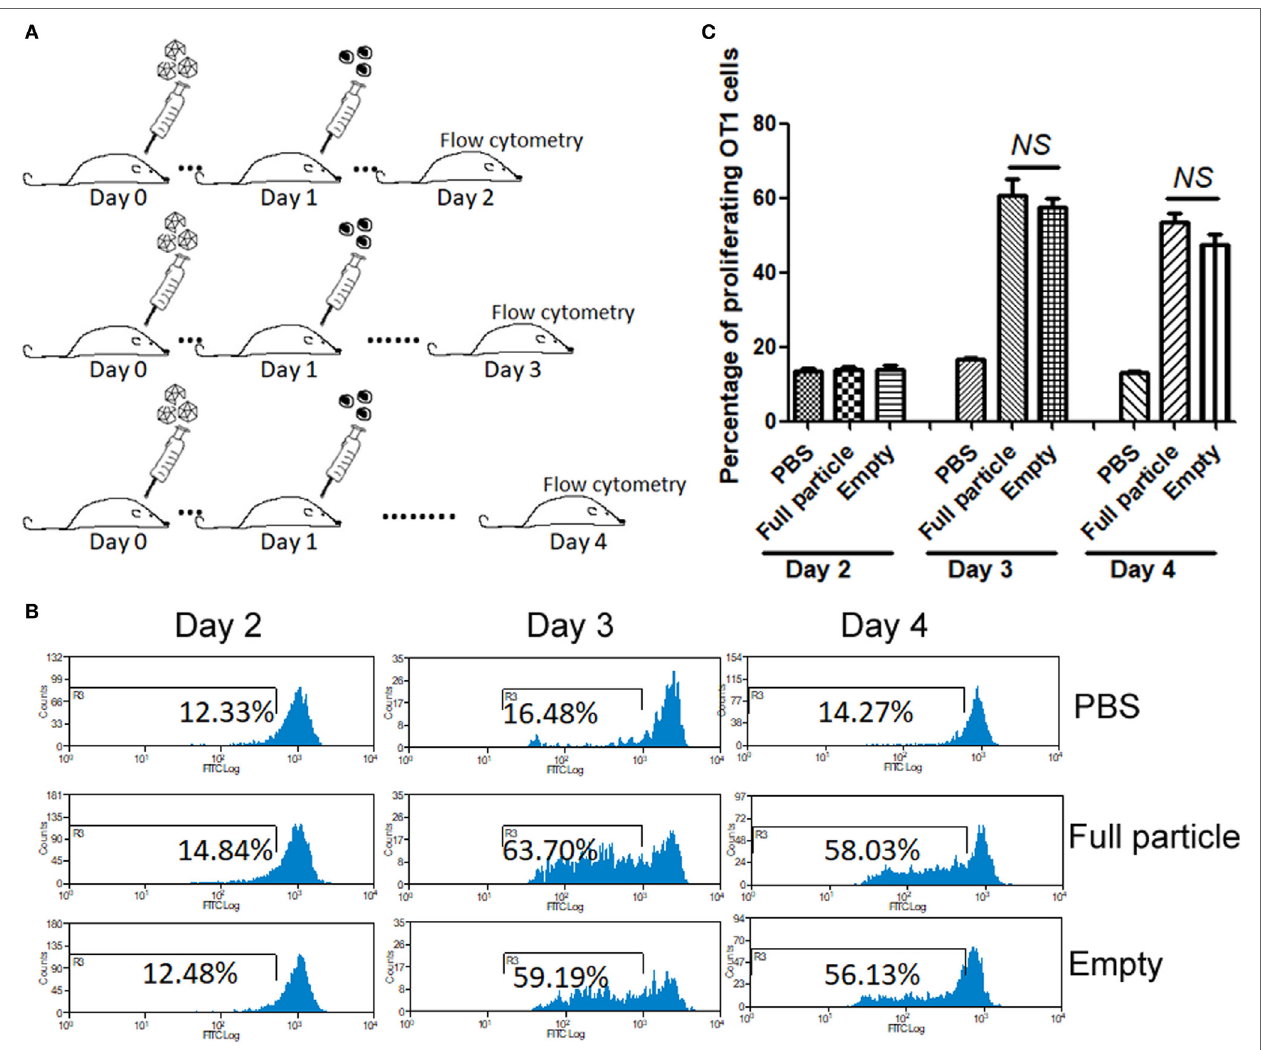
FigUre 3 | Capsid antigen presentation from AAV2OVA empty virions at early time points after administration in mice. 2 × 10 11 particles of AAVOVA viruses were systemically injected via retro-orbital vein into C57BL/6 mice. One day later, CFSE-labeled OT-1 spleen cells were transferred into the mice. At days 1, 2, and 3 post OT-1 cell infusion, the proliferation of OT-1 cells was analyzed by flow cytometry. (a) A scheme for time points of adeno-associated virus administration and OT-1 cells injection as well as assay for OT-1 spleen cell proliferation. (B) Representative flow cytometric histograms. (c) Average T cell proliferation and SD for four